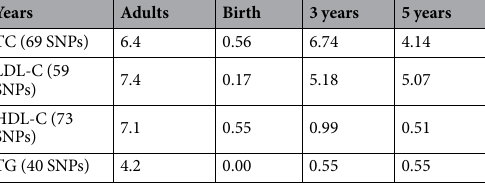
Table 5. Percentage of the variance explained in children by the lipids level associated SNPs at each time of measurement for the different traits. Variances in adults were computed from summary statistic of the consortium data (Willer et al . Nat. Genet